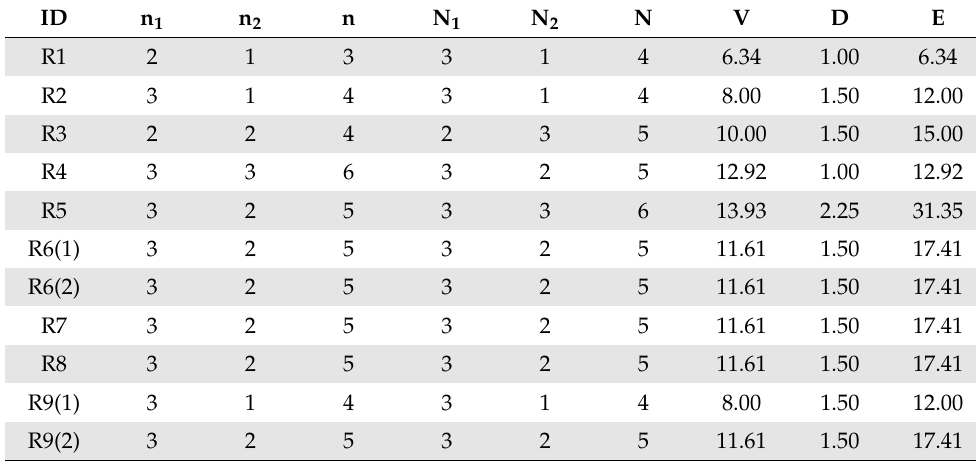
Table A10. Metrics calculations for PCL .